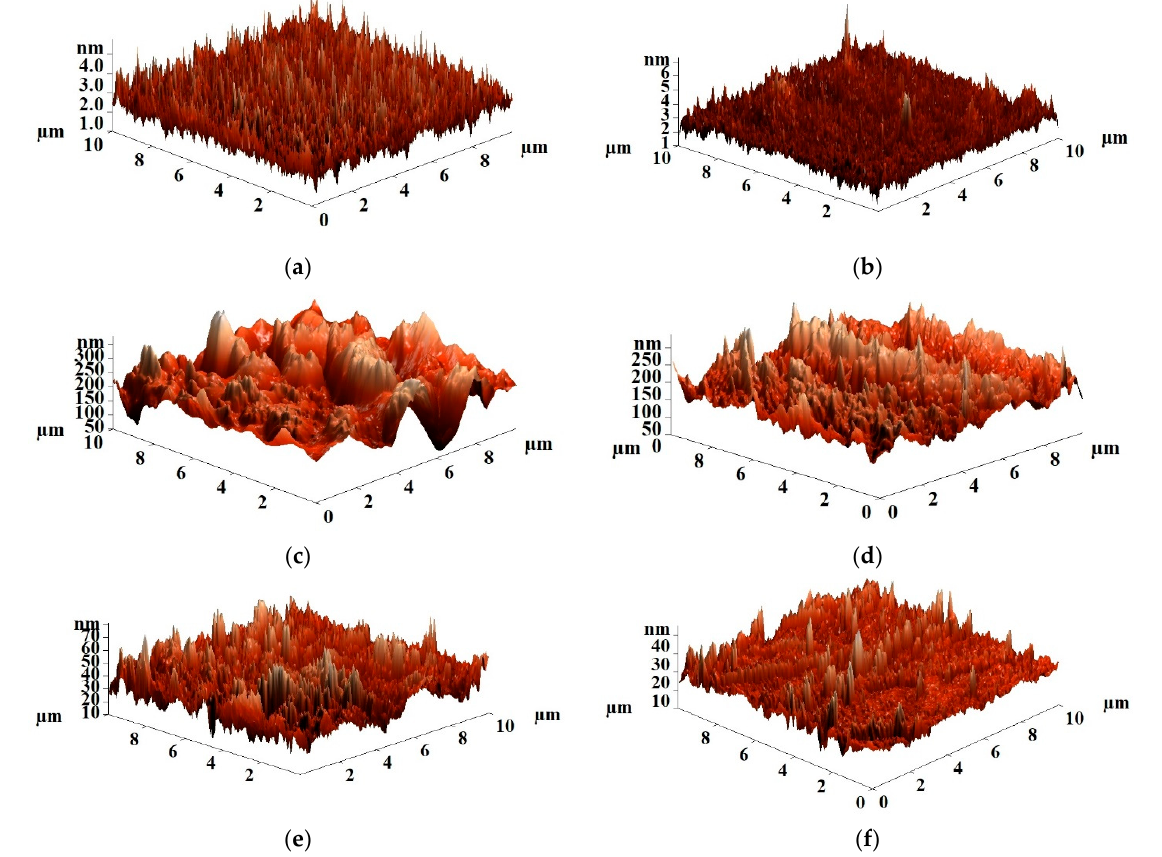
Figure 7. AFM images of the uncross-linked PVA and PVA/Zr-MOFs membranes: ( a ) PVA; ( b ) PVA+MIL-140A(5%); ( c ) PVA+MIL-140A(10%); ( d ) PVA+MIL-140A(15%); ( e ) PVA+MIL-140A- AcOH(10%); and ( f ) PVA+MIL-140A-AcOH-EDTA(10%).